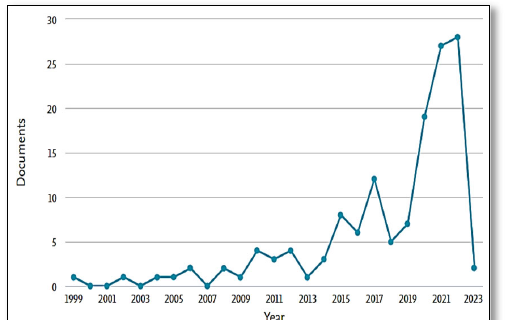
Fig. 1b. Countries that carried out research with the words “Artificial intelligence”, “project management” of “construction”